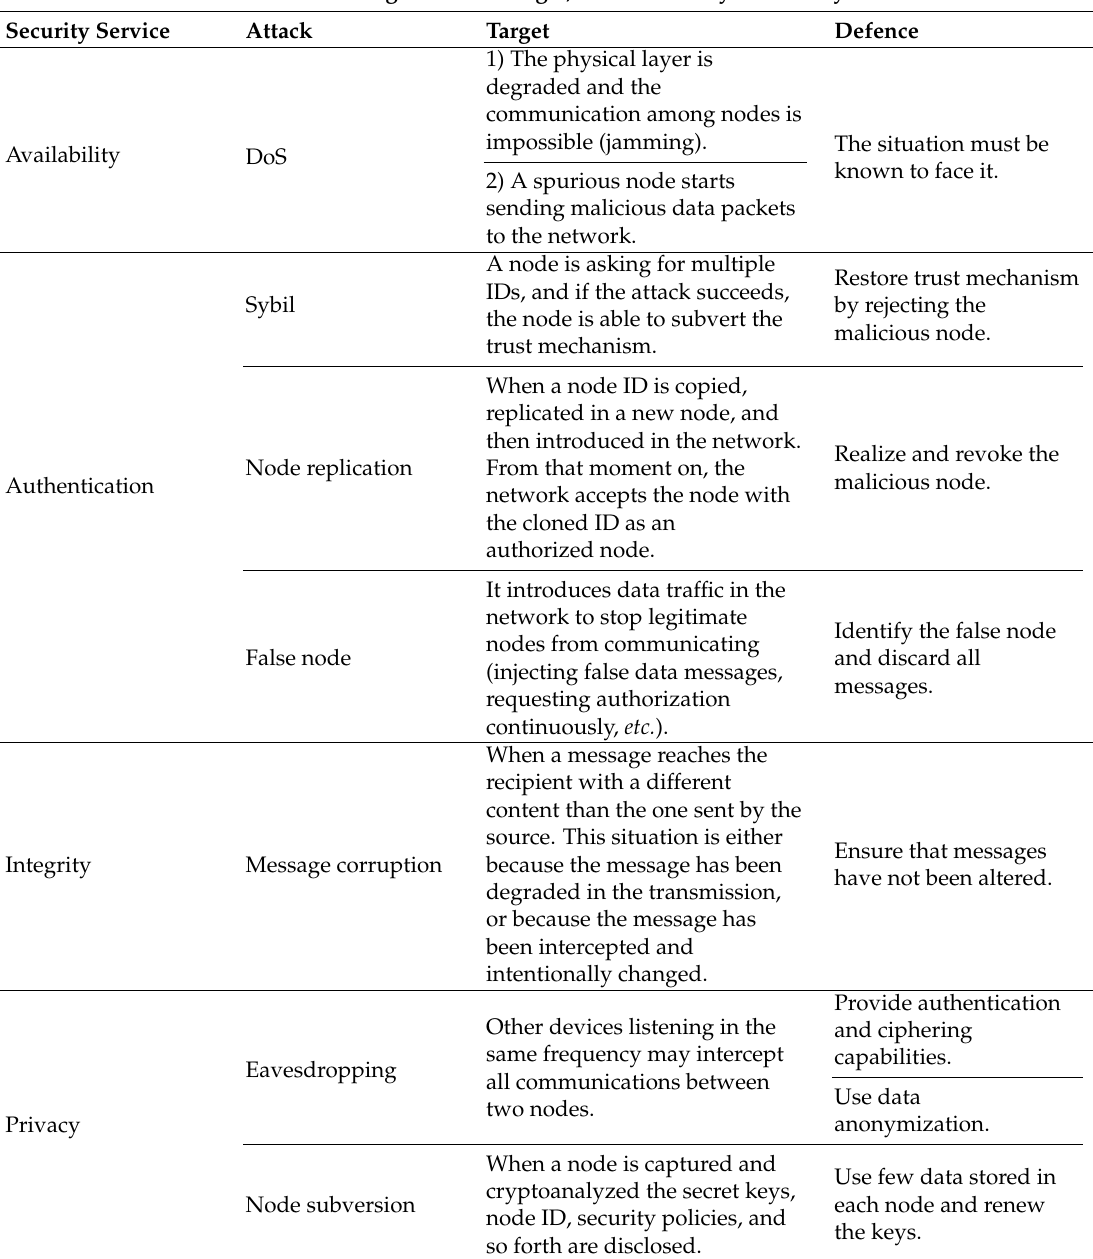
Table 5. Legal Imperatives in DPIA-T